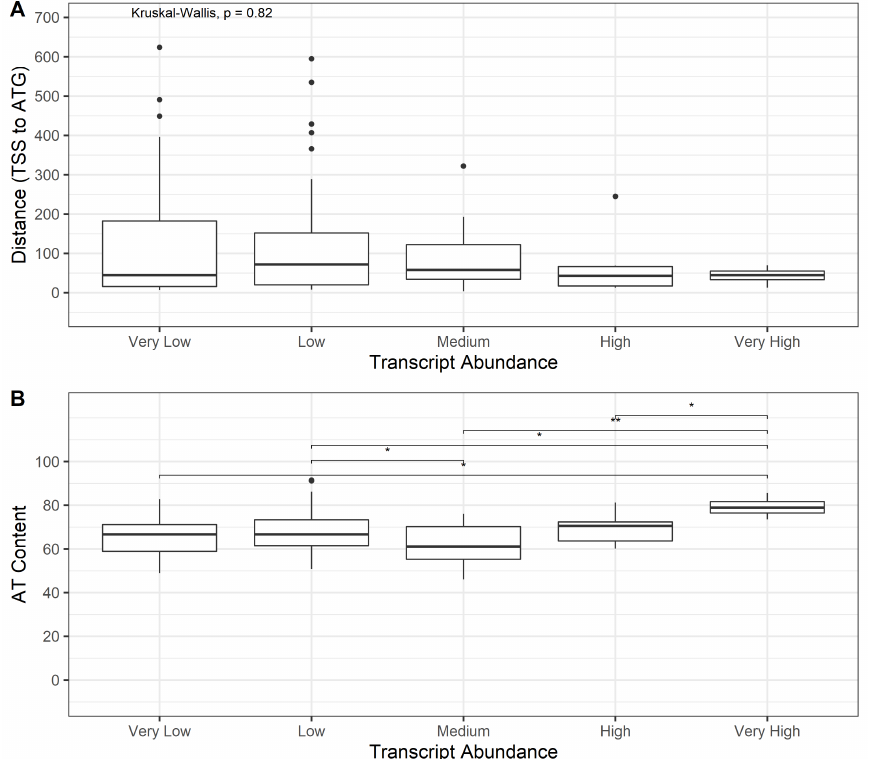
Figure 4. Evaluation of the 5 (cid:48) UTRs of Ac MNPV ORFs categorized according to transcript abundance. ( A ) Length (in nucleotides) and ( B ) A/T content of the 5 (cid:48) UTR between the late gene promoter motif (5 (cid:48) -TAAG-3 (cid:48) ) and translation initiation codon (ATG). * p < 0.05, ** p < 0.01.